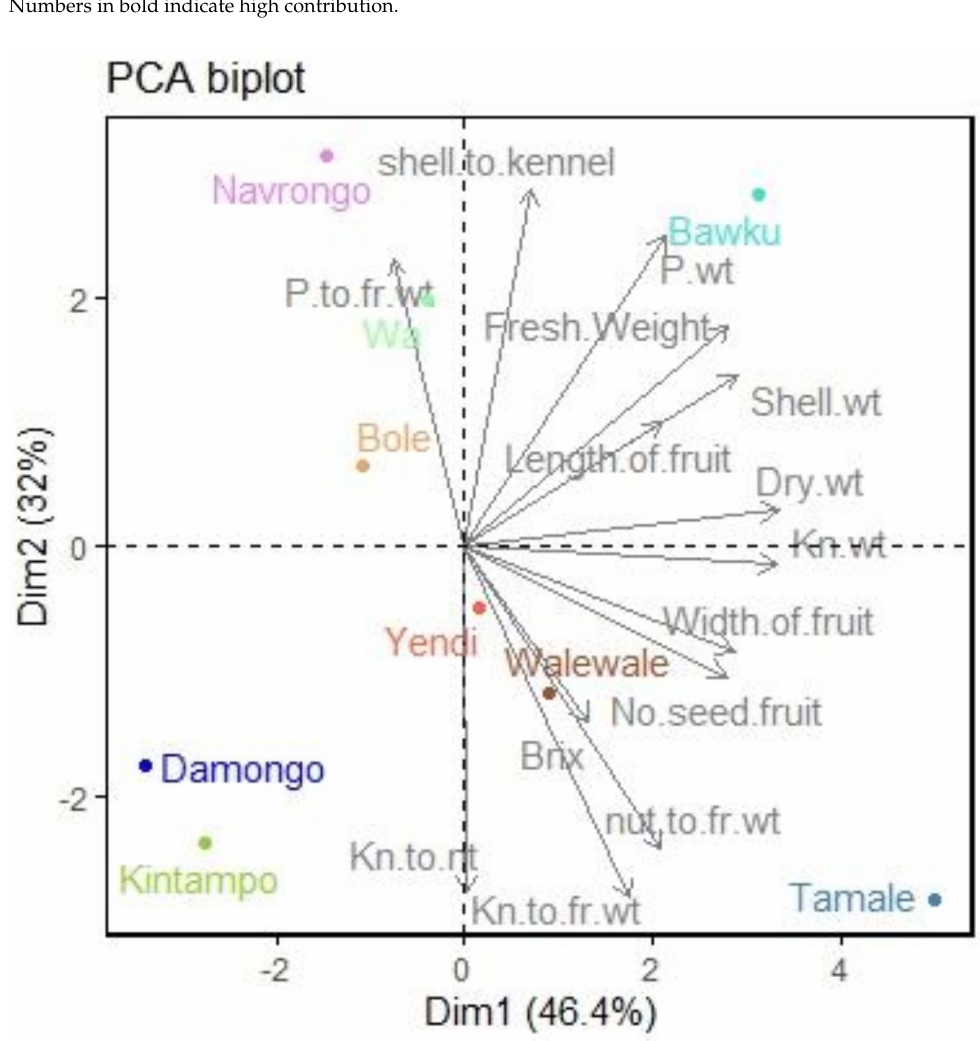
Figure 5. Distribution of germplasms with the first two principal